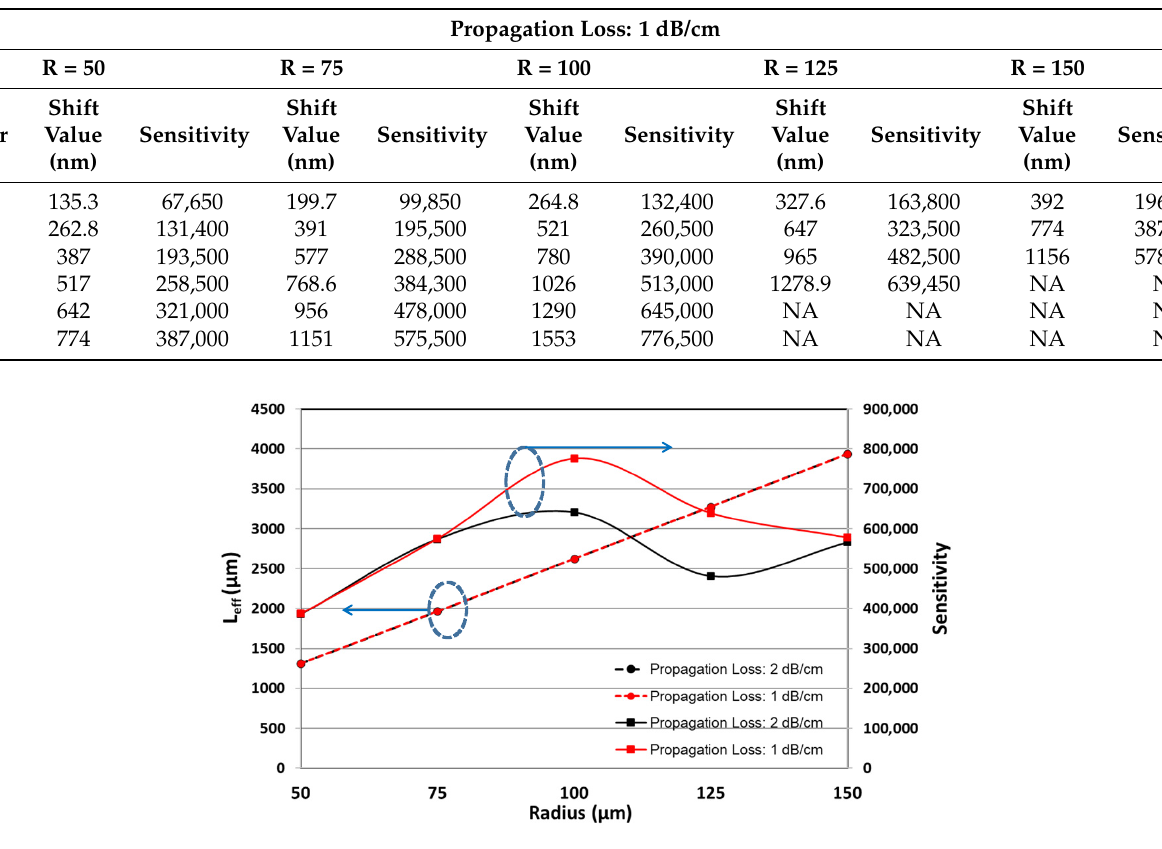
Table 3. The order shift distance and sensitivity for five different MRR radii under two cladding-layer refractive indices—1.31 and 1.312 for 1 dB/cm propagation loss.